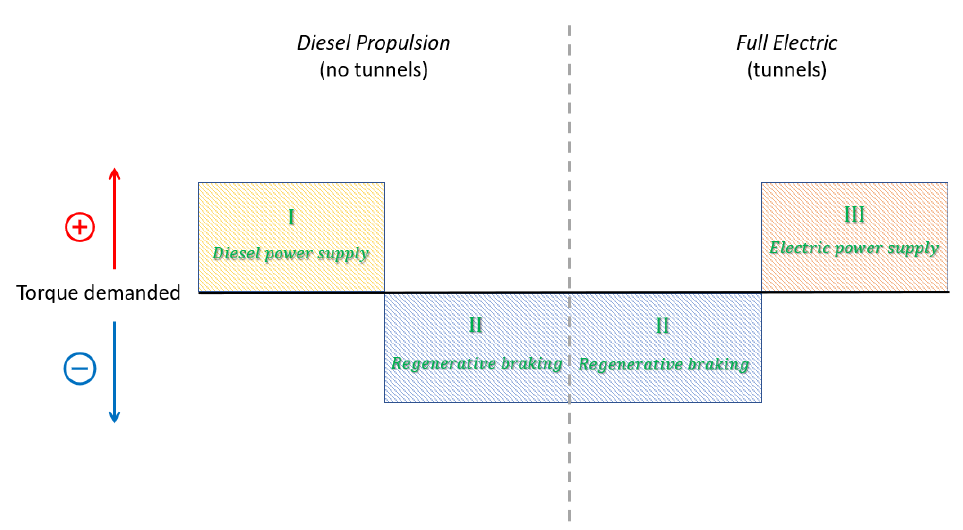
Figure 3. Operative modes according to the torque demanded and the presence of